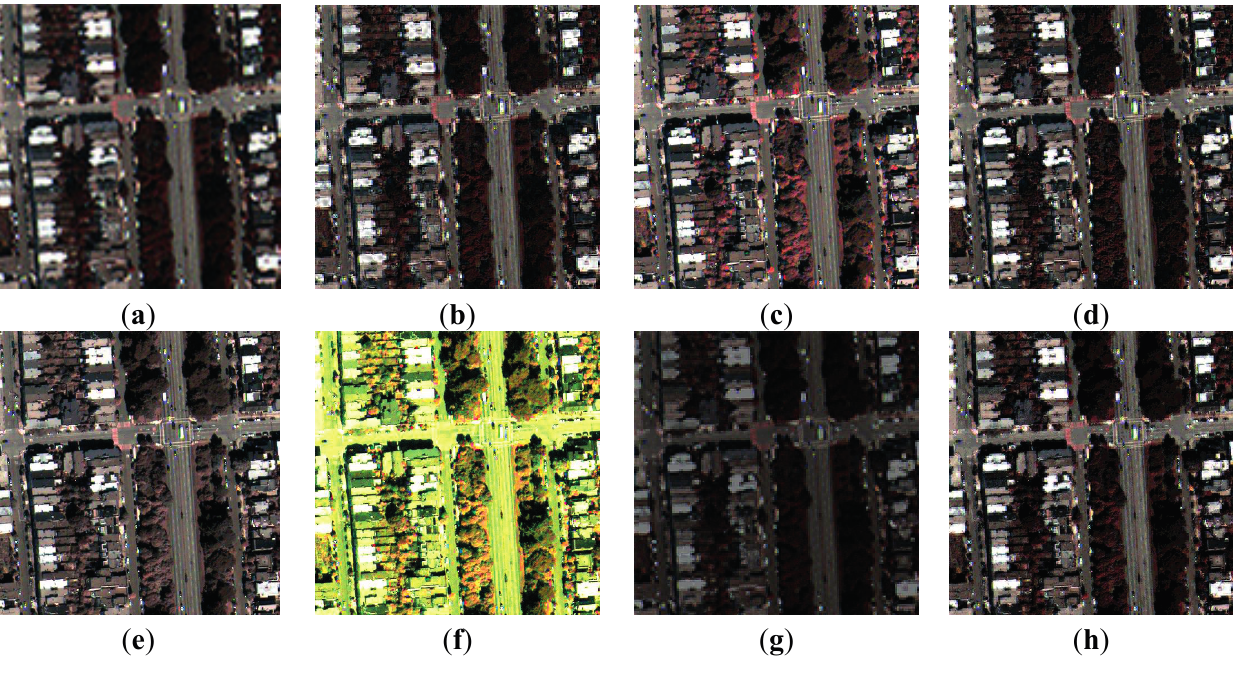
Figure 12. ( a ) Multispectral Image of urban image. ( b ) BEMD fusion image. ( c ) IHS fusion image. ( d ) Wavelet fusion image. ( e ) PCA fusion image. ( f ) Brovey fusion image. ( g ) Gaussian high-pass spatial filter fused image. ( h ) Laplacian pyramidal decomposition